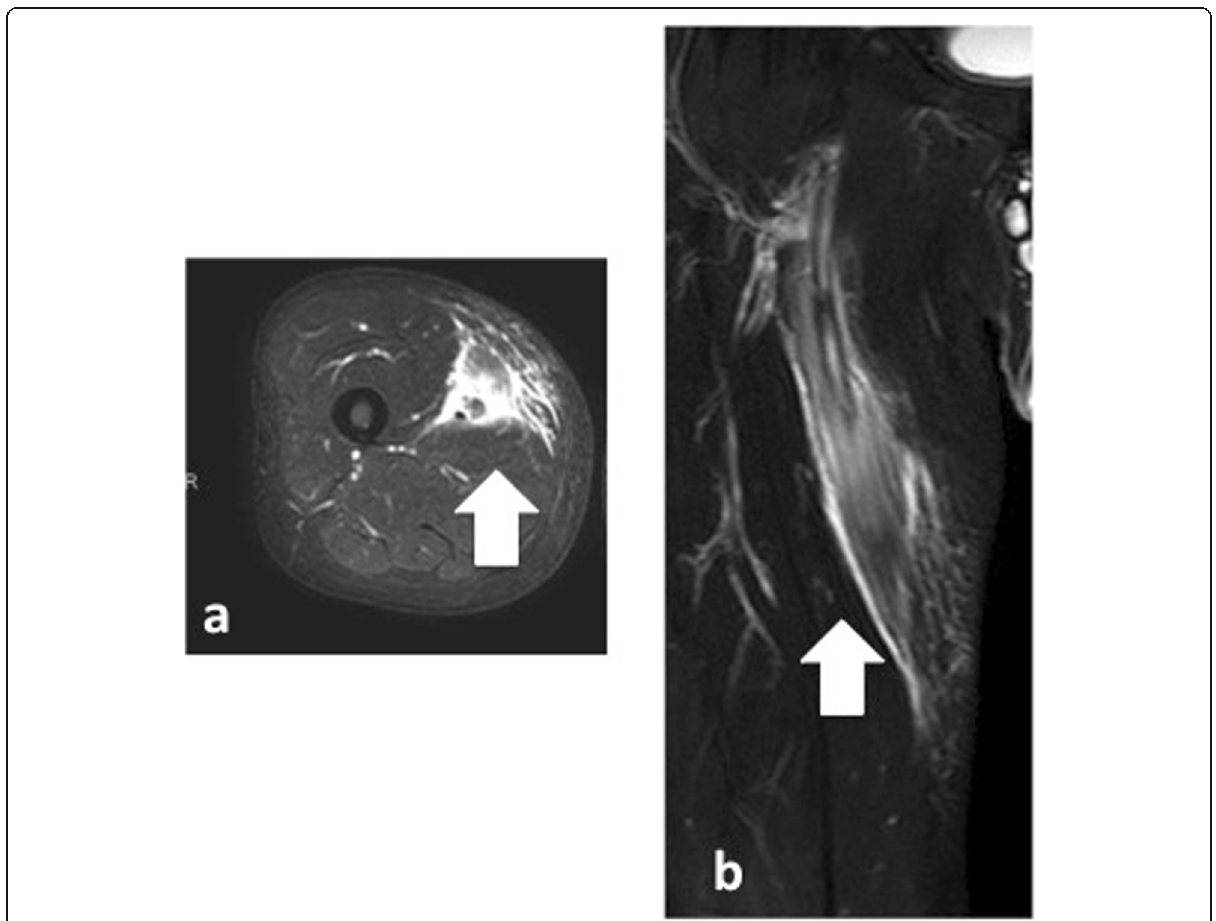
Fig. 2 T2-weighted magnetic resonance images of the patient ’ s thigh. T2-weighted images ( a , axial; b , coronal) revealed perivascular inflammation (arrows: edema of soft tissue) surrounding the superficial femoral